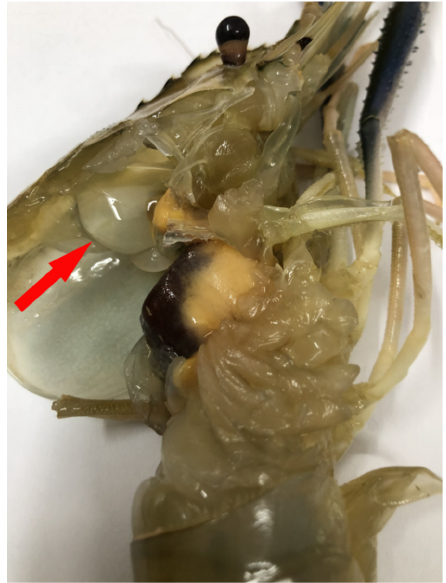
Figure 1. Macrobrachium rosenbergii infected with Citrobacter freundii showing typical signs of WBD under the carapace (red arrow).